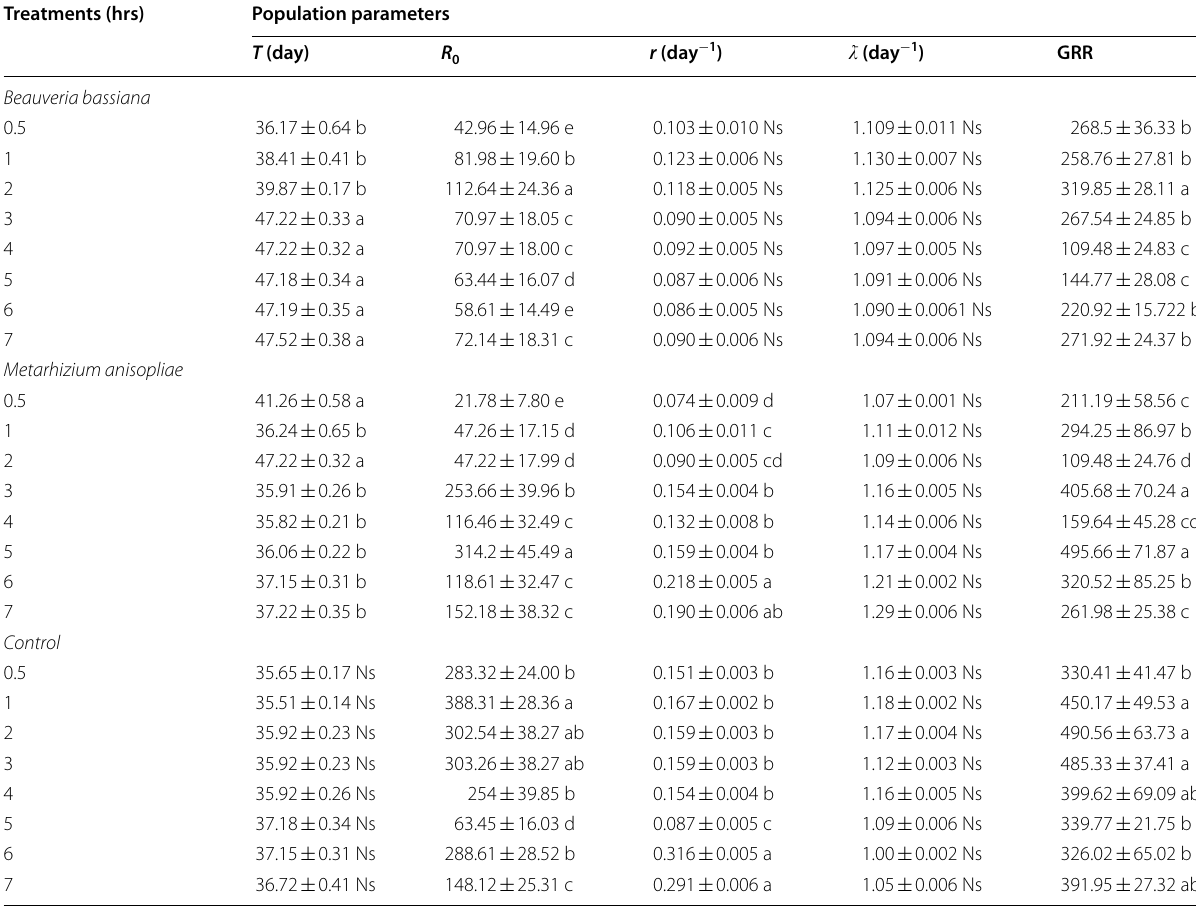
Table 6 Mean parameters ( SE) of the life table of Helicoverpa armigera submitted to different collection times after application of ± the fungi Beauveria bassiana and Metarhizium anisopliae in the field in the soybean crop for the second year (2020) over a generation at 25 1 °C and 70 10% RH ± ±